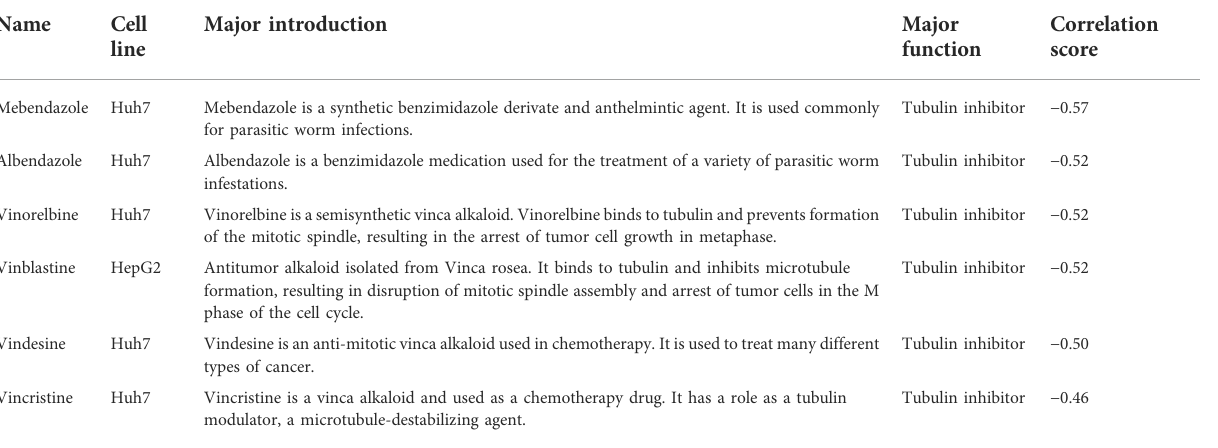
TABLE 2 Top 6 small molecular drug candidates for HCC